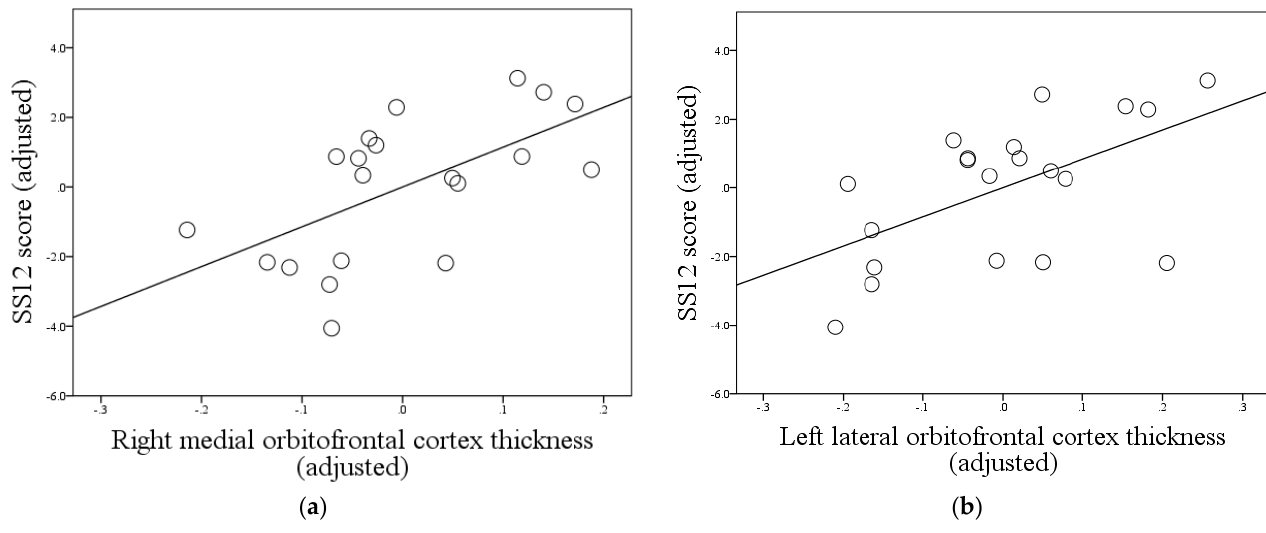
Figure 3. Correlations between SS12 scores and regional gray matter atrophy in patients with Alzheimer’s disease, after adjustment for age, MMSE score, and global cortical thickness: ( a ) correlation between SS12 score and right medial orbitofrontal cortex thickness: r = 0.601, p = 0.00504, p adj = 0.049; ( b ) correlation between SS12 score and left lateral orbitofrontal cortex thickness: r = 0.562, p = 0.00984, p adj = 0.049. SS12 scores are adjusted for age and MMSE score. Regional cortical thicknesses adjusted for age, MMSE score, and global cortical thickness. Multiple comparison correction performed according to the FDR procedure using the Benjamini–Hochberg graphically sharpened method, with a maximum acceptable FDR set at 0.05. Correlation graphs for regions with FDR-adjusted p > 0.05 not shown; 19 comparisons performed in total. Abbreviations : SS12, Sniffin ’ Sticks 12 test; MMSE, Mini Mental State Examination; FDR, False Discovery Rate.